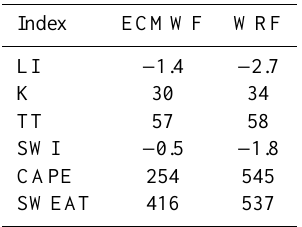
Table 2. Thermodynamic indices for Vrastama tornado’s formation point at 18:00UTC of 12 / 2 / 2010, calculated by RIP software. LI is lifted index, K is K-index, TT is Total Totals Index, SWI is Showal- ter Index, CAPE is Convective Available Potential Energy (Jkg − 1 ), SWEAT Sweat